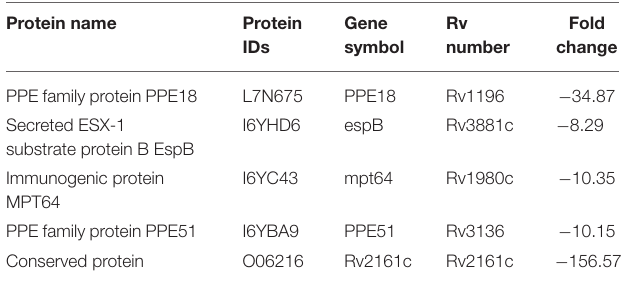
TABLE 2 | List of the M. tuberculosis differentially abundant PPE proteins in M. tuberculosis lineage 7 (L7-35 and L7-28) vs. lineage 4 (H37Rv) strains.